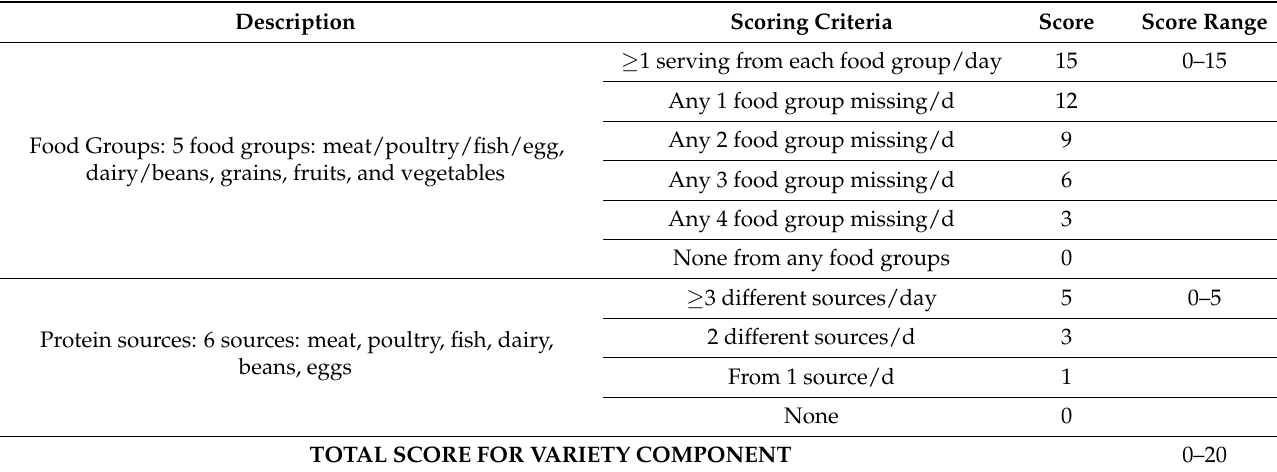
Protein sources: 6 sources: meat, poultry, fish, dairy,